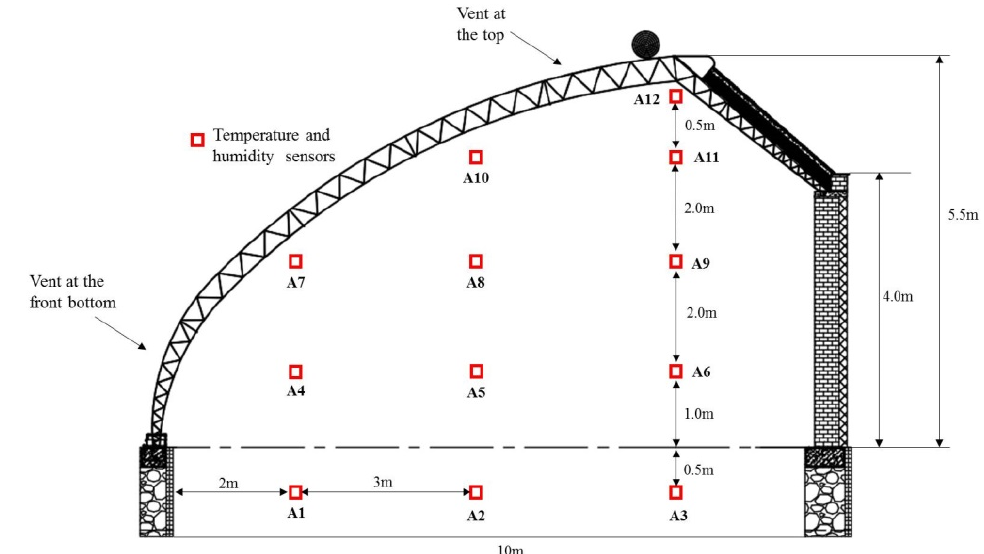
Figure 2. Distribution of measuring points in the experimental testing.